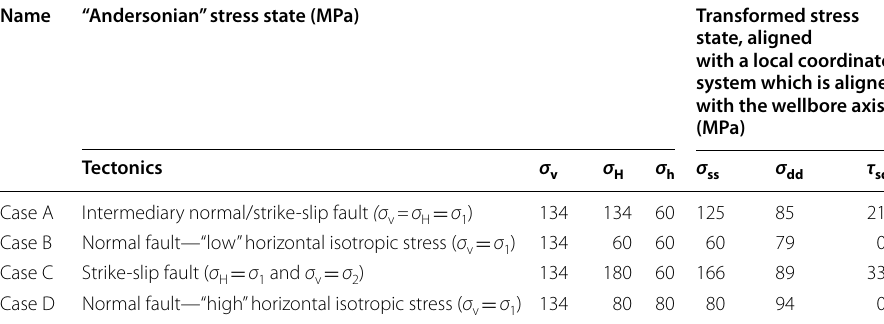
Table 1 Description of the four configurations considered to address uncertainties on the stress state